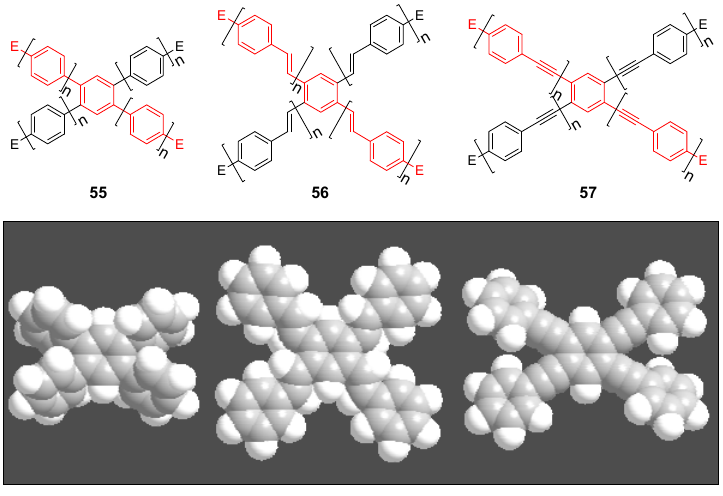
Figure 17. Parent 1,2,4,5-tetrasubstituted benzenes (C-5) with conjugated arms A-3 ( 55 ), A-6 ( 56 ) and A-8 ( 57 ) and their space filling models.